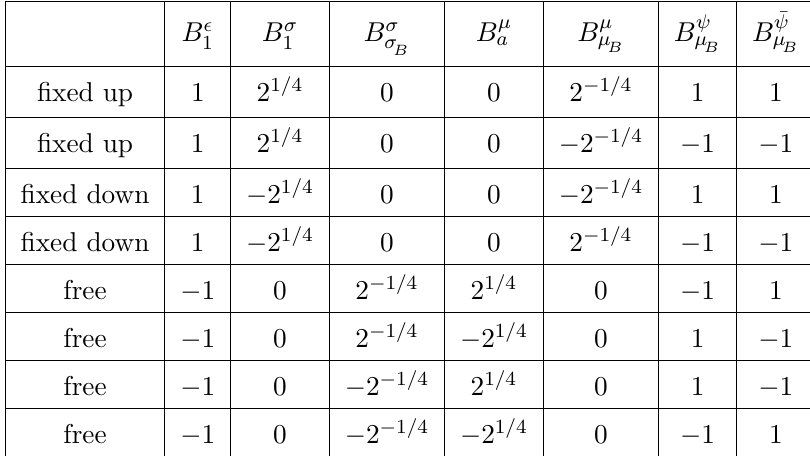
Table 5 . The eight solutions to the full sewing constraints with (cid:21) = i ; the three solutions to the sewing constraints for the standard Ising model are given by the (cid:12)rst three columns of the table.